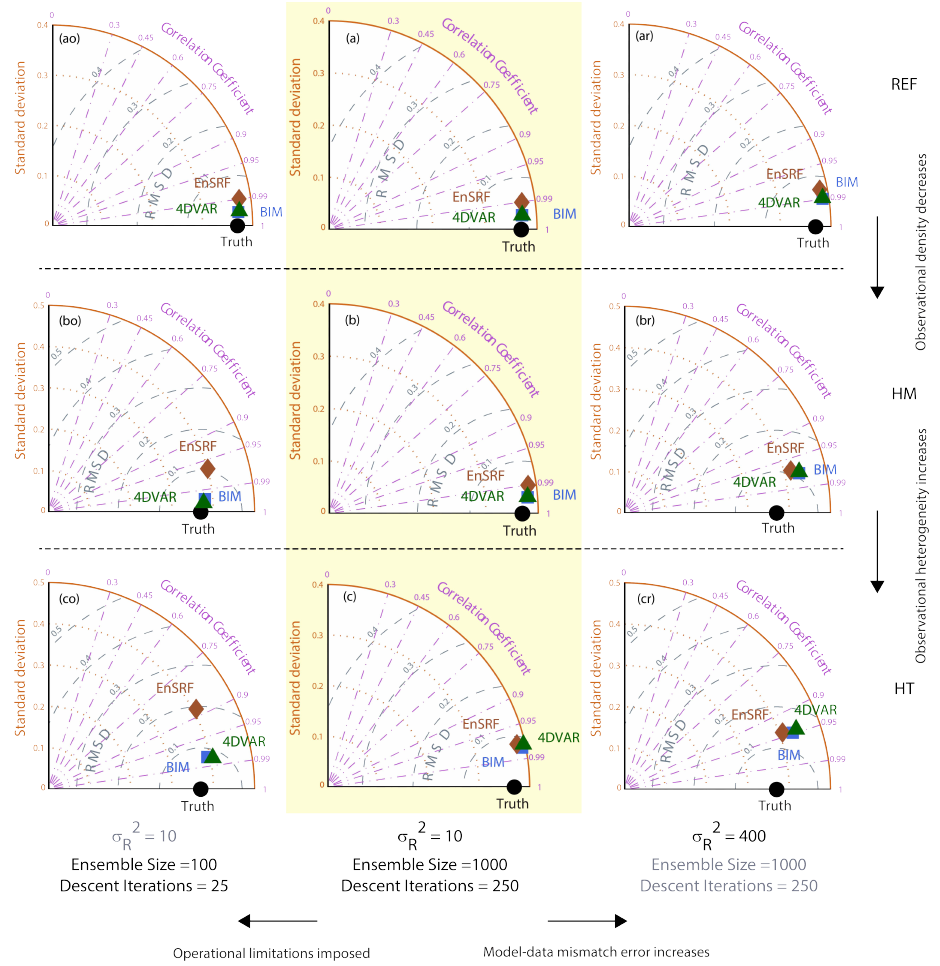
Fig. 6. Performance of BIM, EnSRF, and 4D-VAR at spatially aggregated scales for the different experiments outlined in Table 1. The details of the plot are as described in the caption of Fig.